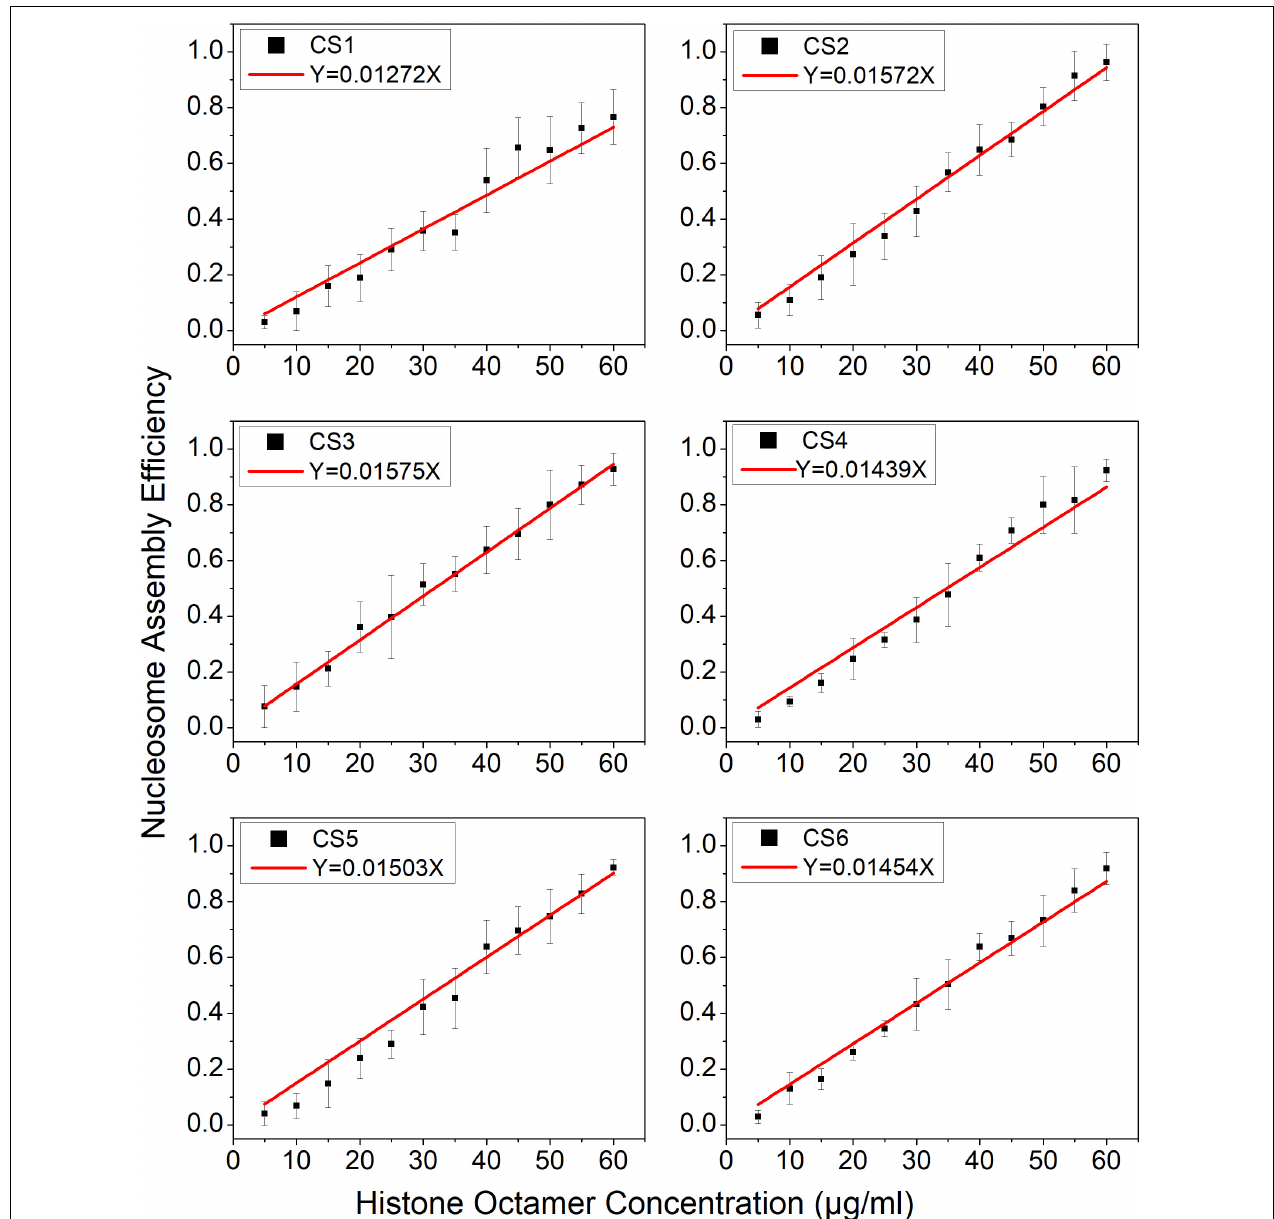
FIGURE 2 | The regression curve of nucleosome assembly efficiency vs. histone octamer concentration for six CS sequences. The nucleosomes were reconstituted on CS1–CS6 DNAs with different histone octamer concentrations. Reconstituted nucleosomes were analyzed by native-PAGE and quantized to calculate the nucleosome assembly efficiency. For each sample, five independent repeats were